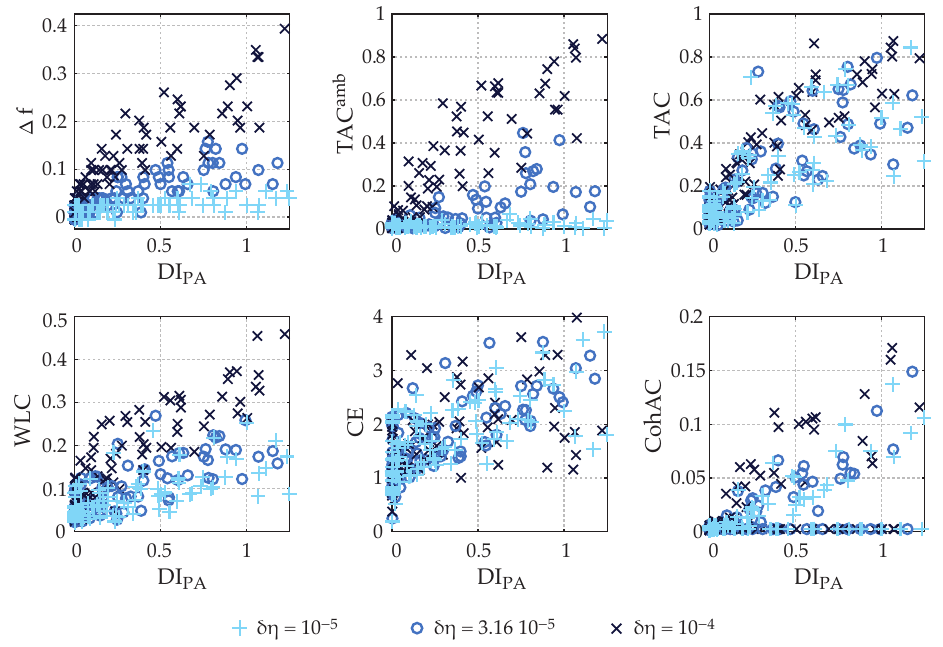
Figure 14. Correlation of six DSFs with respect to the Park and Ang DI ( DI PA ) for three nonlinear models that are defined by changing the stiffness degradation parameter ( delta η ). Two DSFs are derived from post-earthquake AVs: ∆ f ( top left ) and TAC amb ( top center ). Another two DSFs are derived with short moving time windows: TAC ( top right ) and WLC ( bottom left ). The final two DSFs are derived from the entire GM signal: CE ( bottom center ) and CohAC ( bottom right ). All DSFs are derived for the first mode and for an input sensor at the ground and an output sensor at M 5 , as defined in Figure